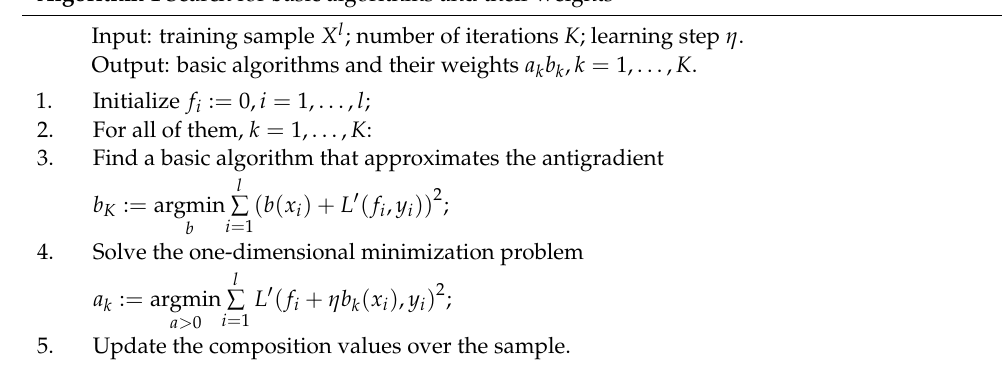
Algorithm 1 Search for basic algorithms and their